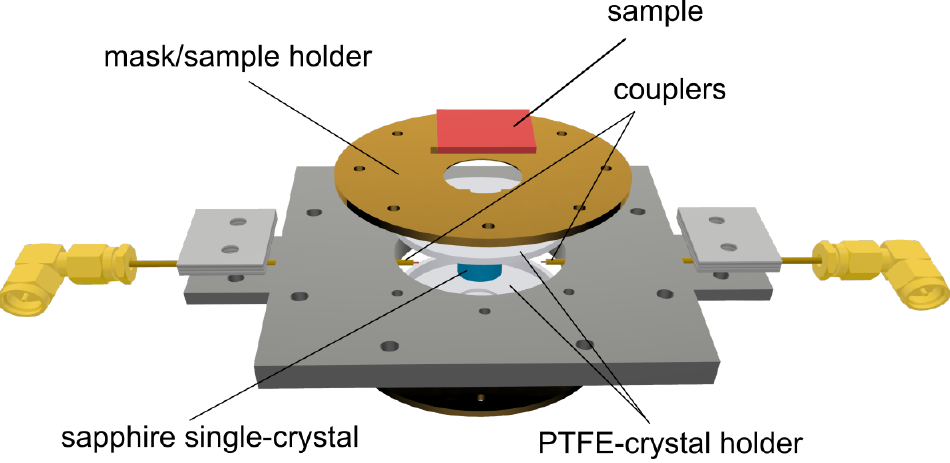
Figure 2. Three-dimensional exploded view of the DR